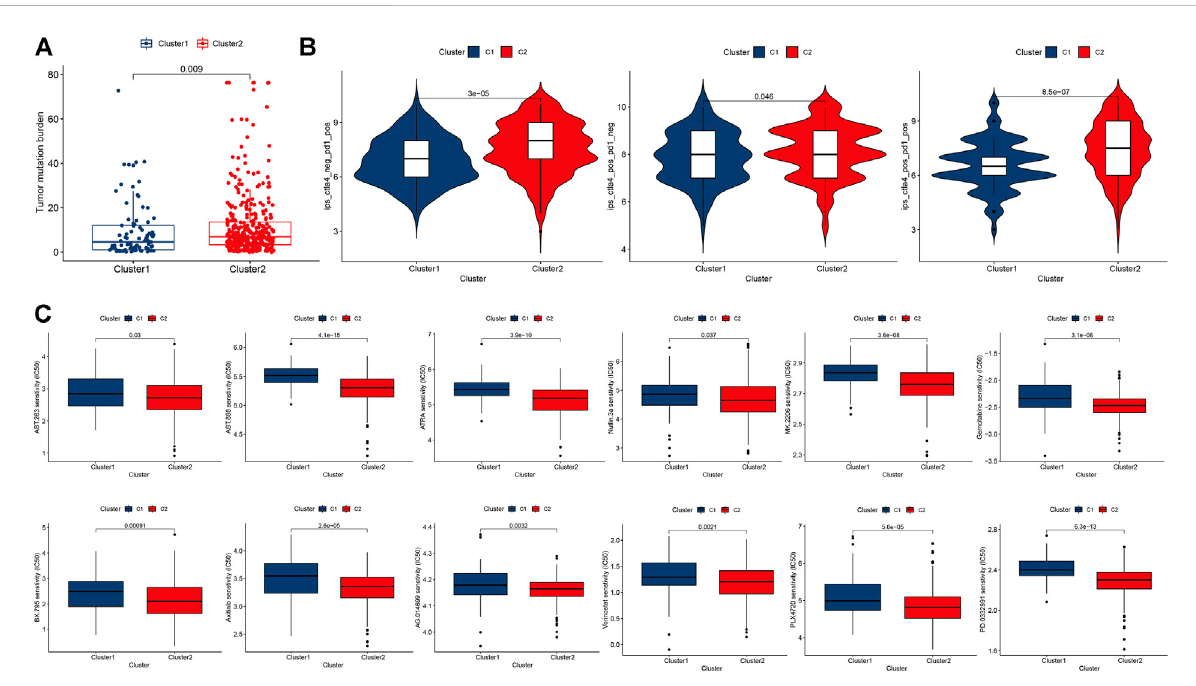
FIGURE 4 Comparisons of TMB, immune checkpoint gene expression, and drug sensitivity between two clusters of CM cases. (A) Levels of TMB in two clustersofCM cases. (B) PD-1 and/or CTLA4 intwoclusters ofCMcases. (C) Predictionofpotential therapeutic drugsIC 50 intwoclusters ofcases.A p value of < 0.05 was considered to indicate a statistically signi fi cant